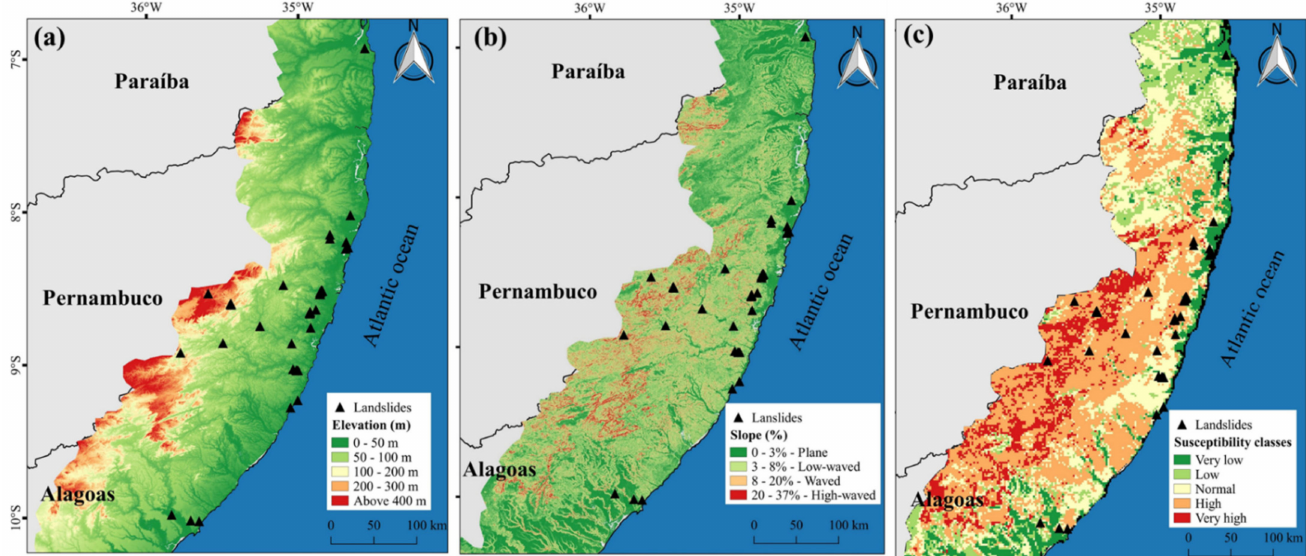
Figure 4. Spatial distribution of elevation ( a ), slope ( b ), and susceptibility ( c ) in the ECNEB municipalities. The black triangular points represent the landslides recorded in the period from 23 to 30 May 2017.